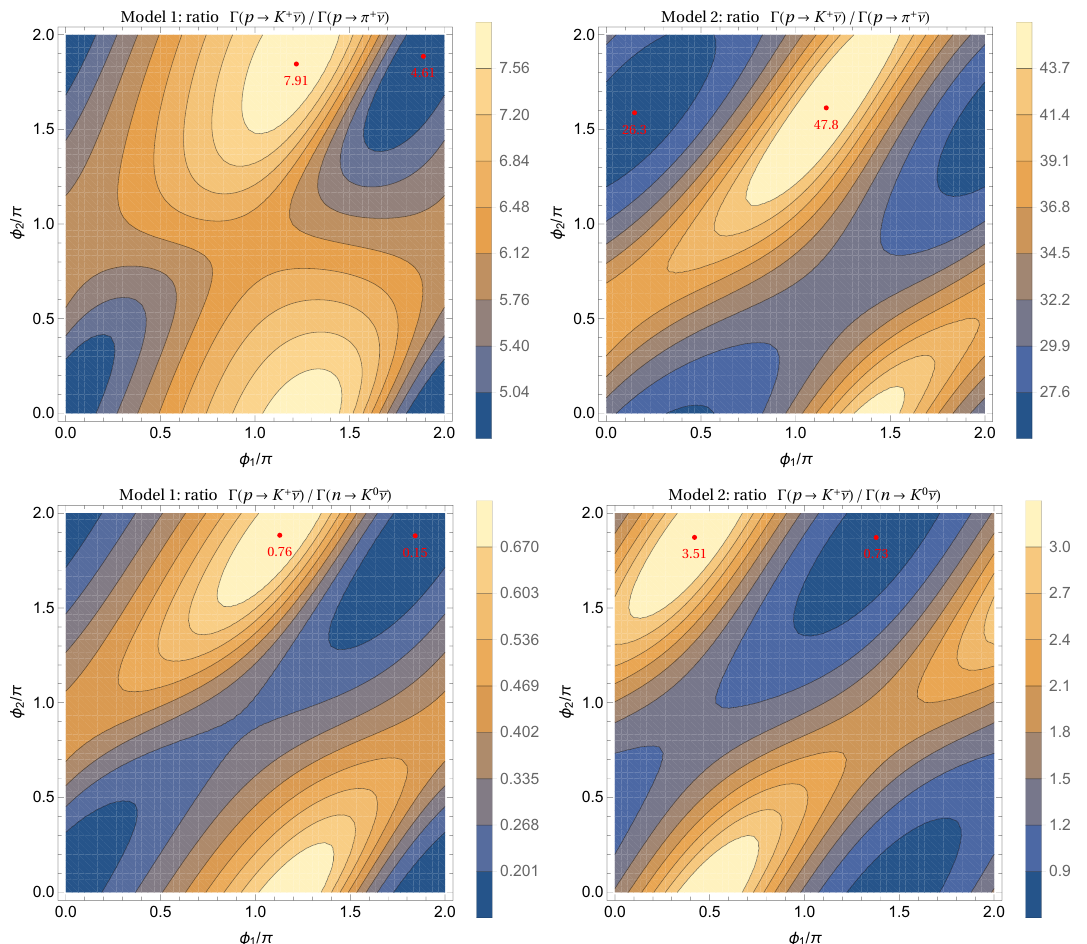
Figure 3 . Contour plots for the GUT phase dependence of the decay rate ratios Γ (top) and Γ (bottom) for the best-fit points of model 1 (left) and model 2 (right). / Γ p → K + ¯ ν n → K 0 ¯ ν The results are independent of the effective triplet mass M eff